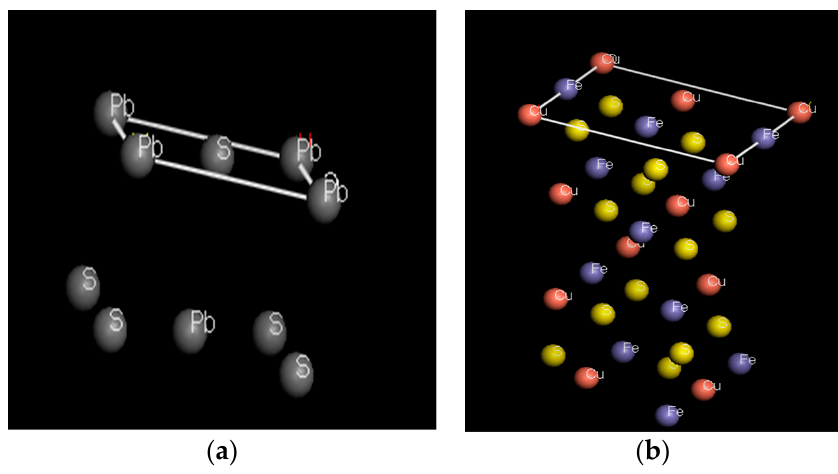
Figure 6. Infrared spectra of galena with IPETC at different pH.